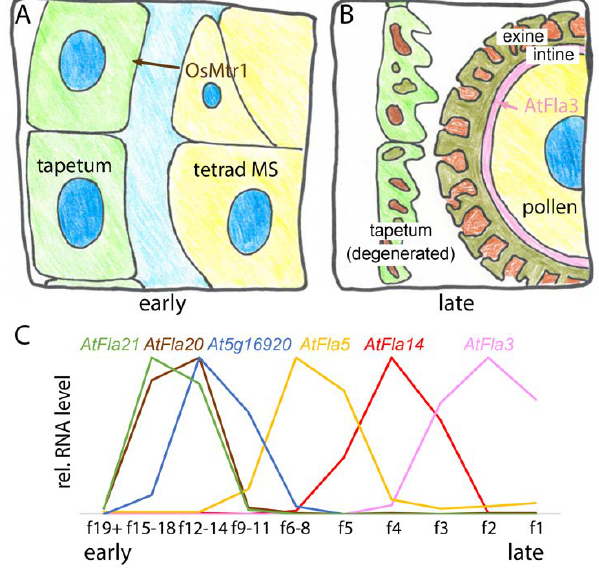
Figure 7. FAS1 proteins act sequentially in male gametophyte development: ( A ) OsMtr1 acts in early stage of tapetum development. It is specifically expressed and secreted in microspore cells (MS) and influences the development of tapetum cells; ( B ) AtFla3 acts at the late stage of the formation of the cellulose- and pectin-rich intine layer of pollen cell walls; ( C ) RNA-Seq data of Arabidopsis thaliana at different floral stages [164,165] show that six FAS1 genes are specifically expressed in anthers at different stages of floral development. f1 indicates the first open flower. The expression patterns of AtFla20 that might be the ortholog of OsMtr1 and of AtFla3 are consistent with roles in early and late pollen development, respectively.